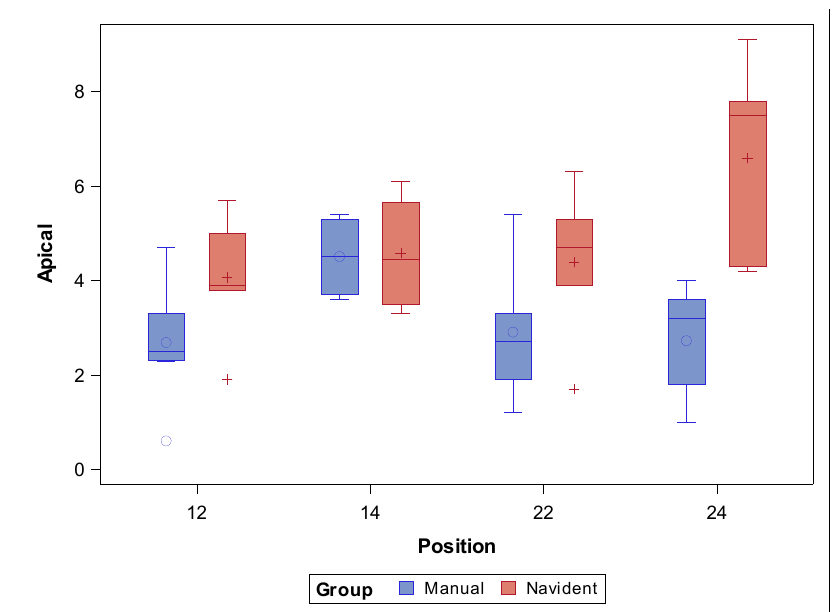
Figure 5. Box plot of deviations at the coronal entry point observed in the study groups and ZI positions. Median values are represented by the horizontal lines within each box. The symbols represent extreme values.